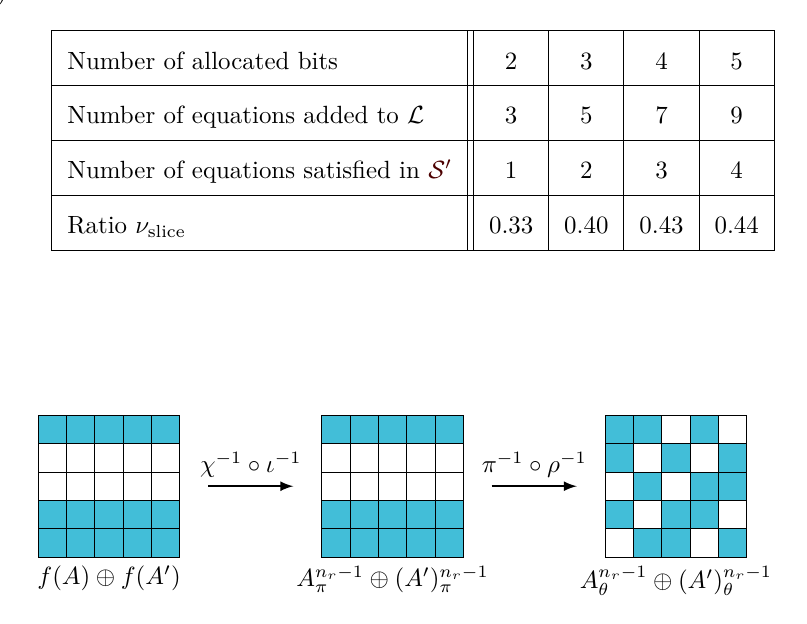
Figure 9: Illustration of the effect of the Keccak mappings when the outer state is two planes.